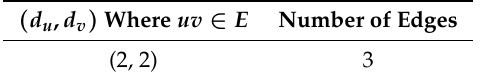
2 ) on the basis of degrees of end vertices of each edge. ≥ ( d u , d v ) Where uv E ∈